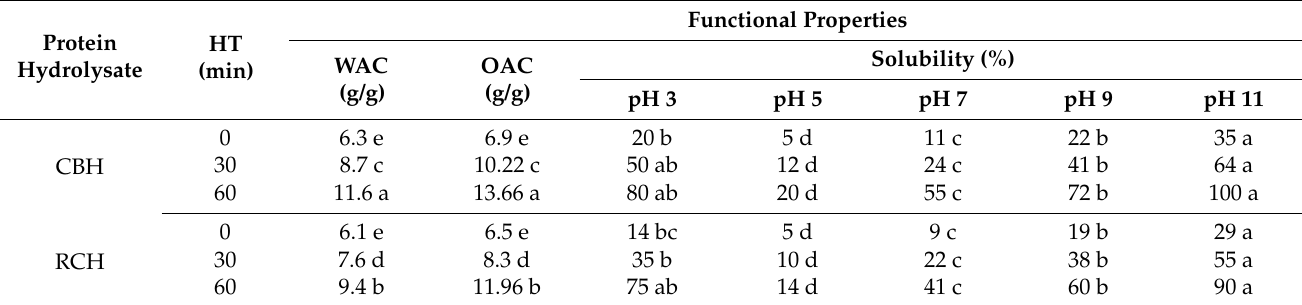
Table 2. Functional properties (water-absorbing capacity, oil-absorbing capacity, and solubility) of CBH and RCH were obtained after 60 min of pepsin hydrolysis at 37 ◦